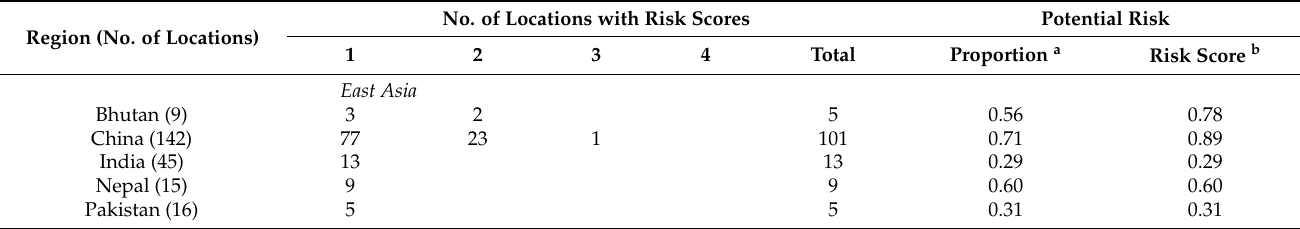
Table 2. Locations of potential infection risk from Puccinia graminis f. sp. tritici in Asian and Southeast European countries. Region (No. of